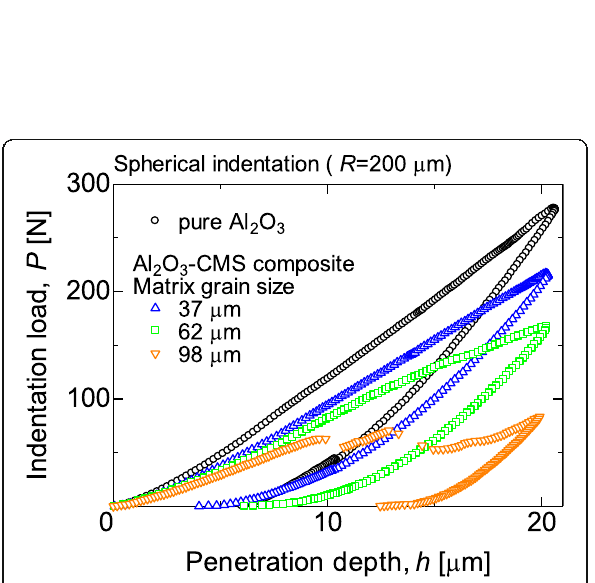
Fig. 6 Hysteresis curves of indentation load and penetration depth of 1.0 vol% CNP-Al 2 O 3